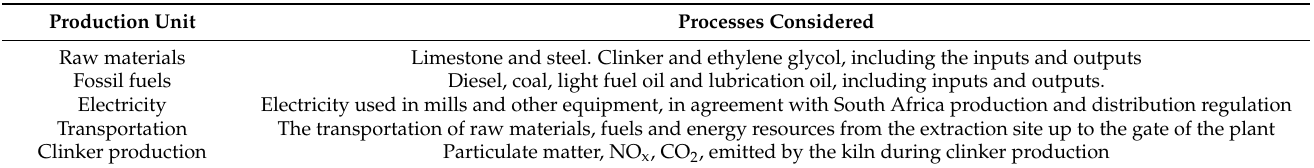
Table 3. Processes studied in each production stage of Portland cement in South